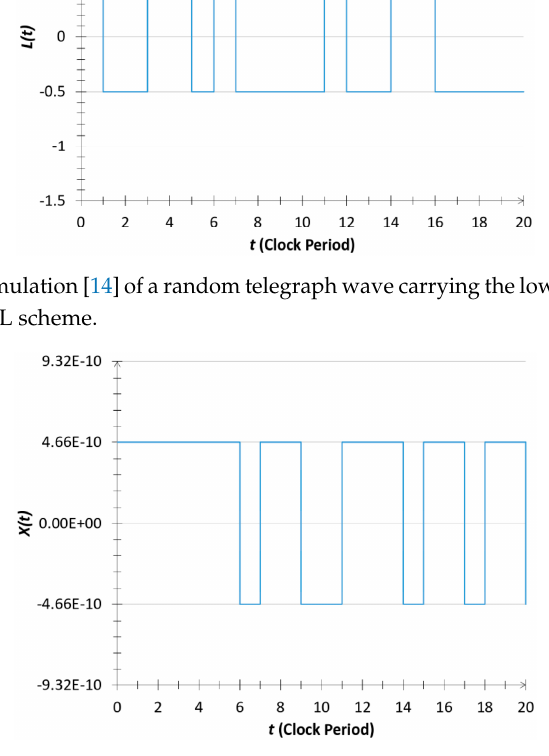
Figure 5. Computer simulation [14] of the product-string of the number 2 (binary number 00000000000000000000000000000010) in an M = 32 noise-bit INBL scheme.